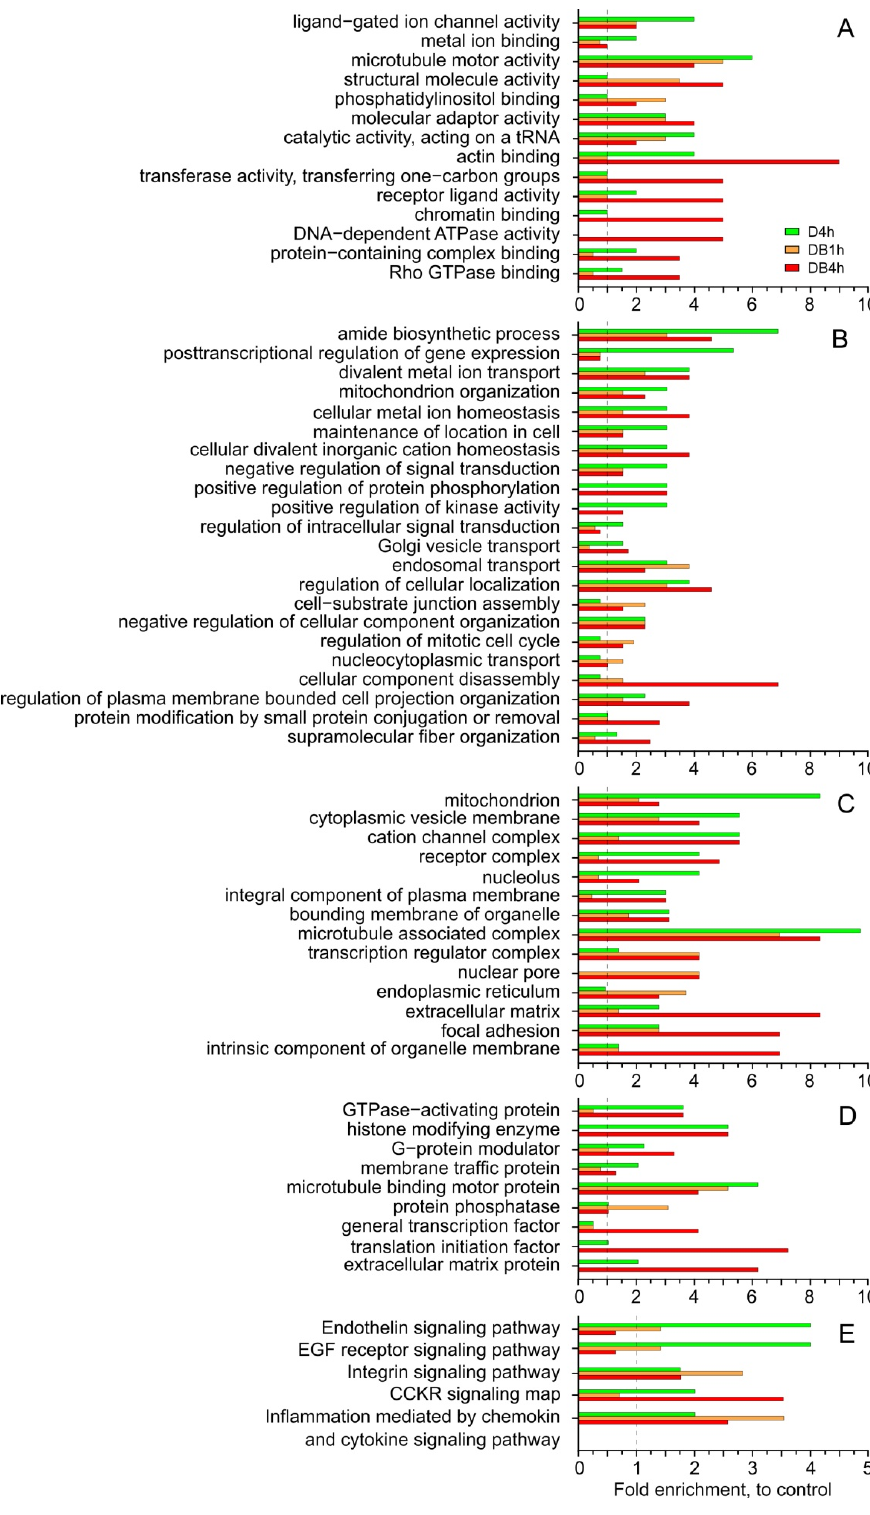
Figure 2. Enrichment analysis of PANTHER GO-slim annotation in experimental samples relative to untreated control HEp-2 cells. ( A ) Molecular functions (MFs). ( B ) Biological processes (BPs). ( C ) Cellular component (CCs). ( D ) Protein class (PCs). ( E ) Signaling pathways. The y -axis shows the groups with significantly enriched values ( p <